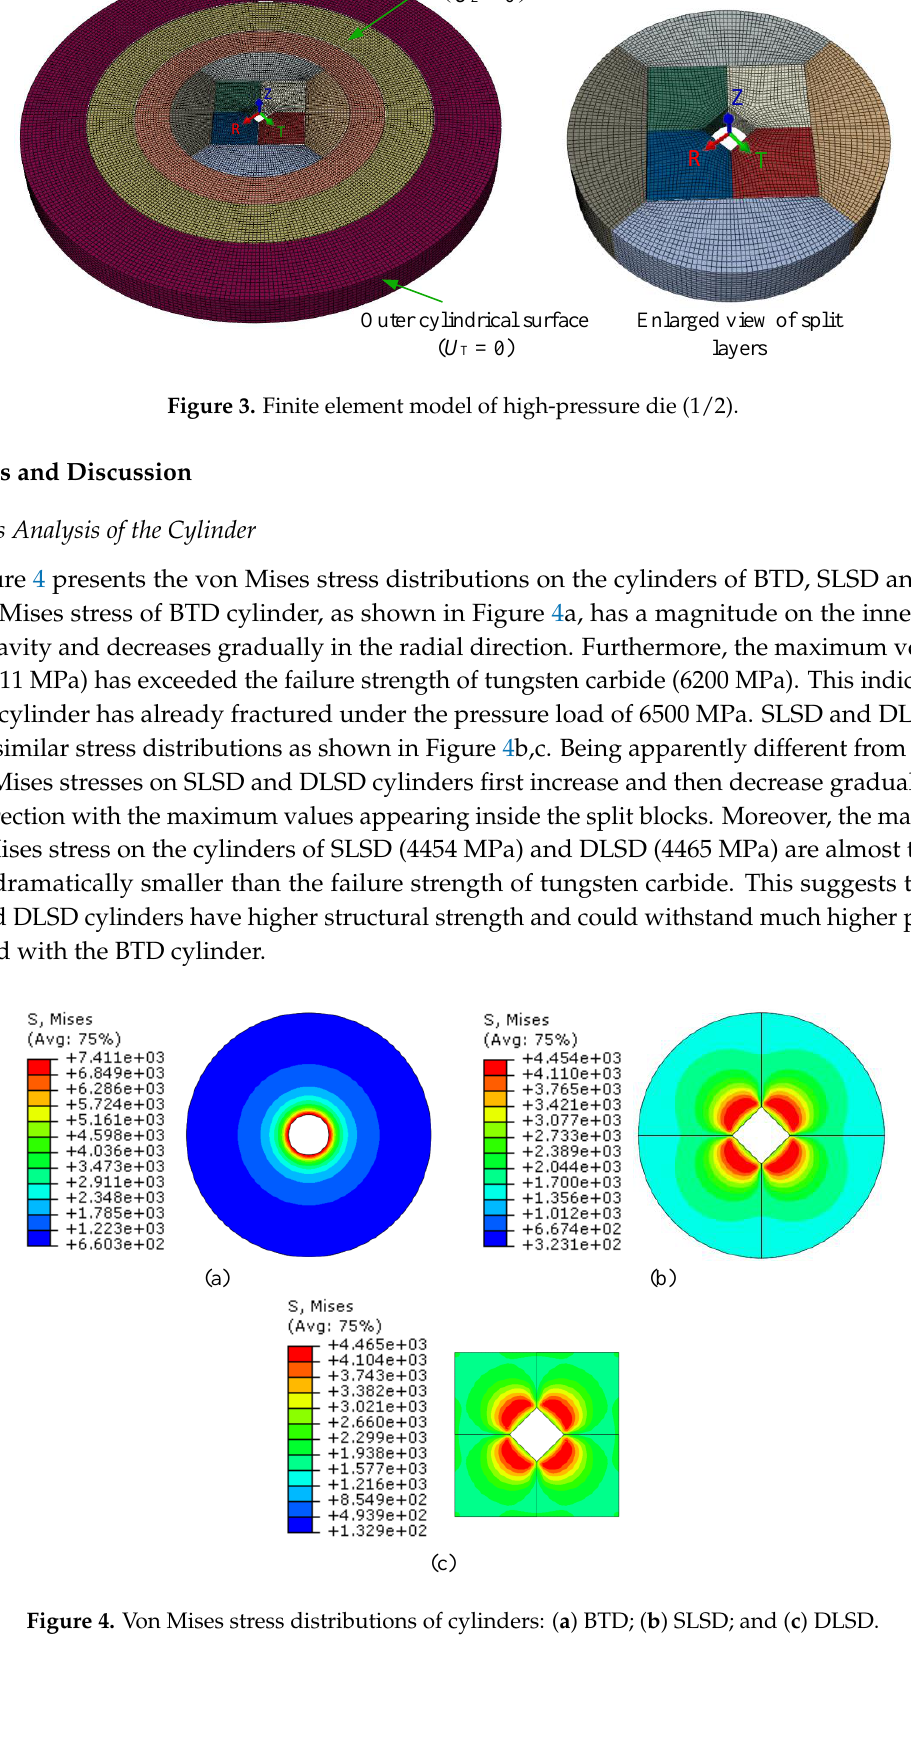
Figure 4. Von Mises stress distributions of cylinders: ( a ) BTD; ( b ) SLSD; and ( c ) DLSD.